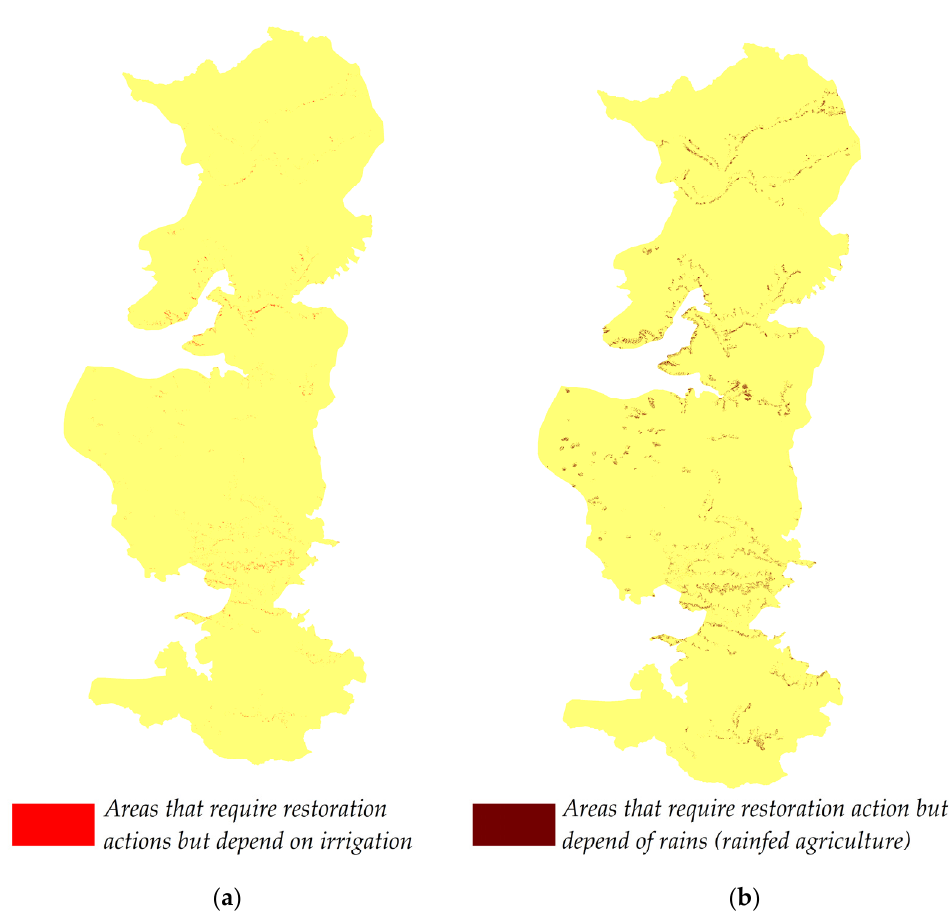
Figure 8. Description of the hillside systems in the coastal mountain range able to be recovered considering two restoration options: ( a ) areas with availability of irrigation from the canals currently present in the study area; ( b ) areas that could be restored for agriculture with rainfed irrigation, which is not currently carried out due to the prolonged drought that affects the study area.